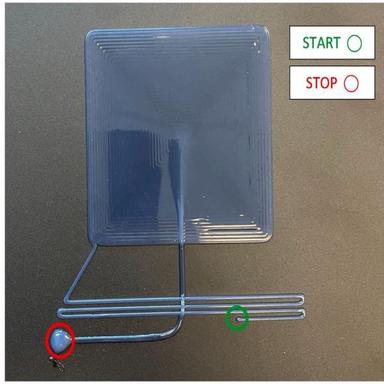
Image of a printed coupon with lead-in and lead-out. The green circle indicates the start of the print, while the red circle shows the end. The resin is translucent off-white, but appears blue due to the black backing and the ambient lighting.